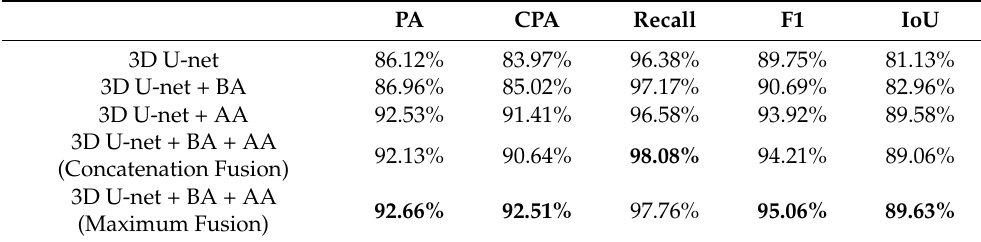
Table 3. Cloud extraction accuracy for modules and variants of the model.